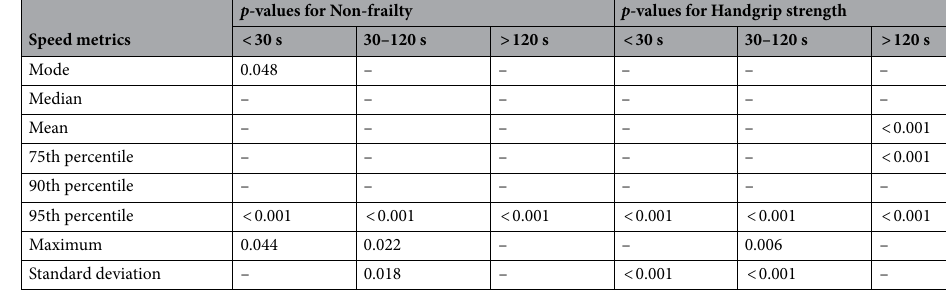
Table 4. Summary of results of stepwise regression forward models for identification of non-frailty condition and prediction of handgrip strength, (CoLaus cohort, Lausanne, Switzerland, 2014–2017). s seconds. ‘–’The variable did not remain in the stepwise approach. The table reports the significant p -values obtained by using each speed metric within each bout duration